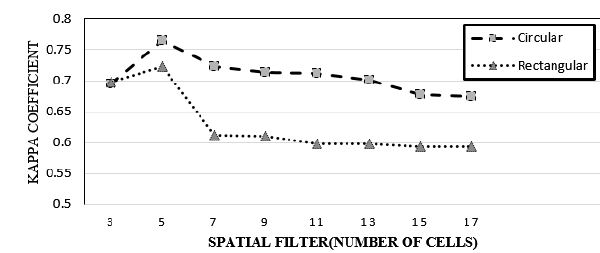
Figure 5. Change in kappa index response for two different type and spatial filter